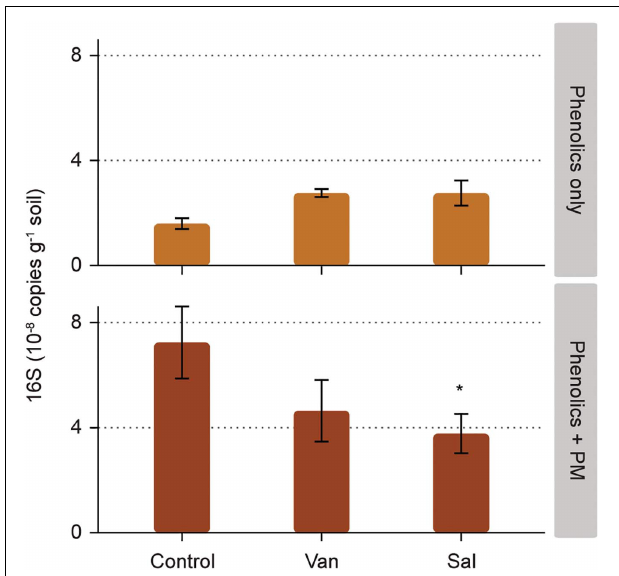
FIGURE 3 | Effect of phenolic acids on bacterial numbers, as measured in the soil compartment of rhizosphere simulation microcosms. Phenolic acids were vanillic acid (Van) and salicylic acid (Sal), applied alone and with a background of soluble primary metabolites (PM). Significant differences to the control (water and PM only, respectively) are shown for phenolic acids without and with PM (* 0.05 > p > 0.01).